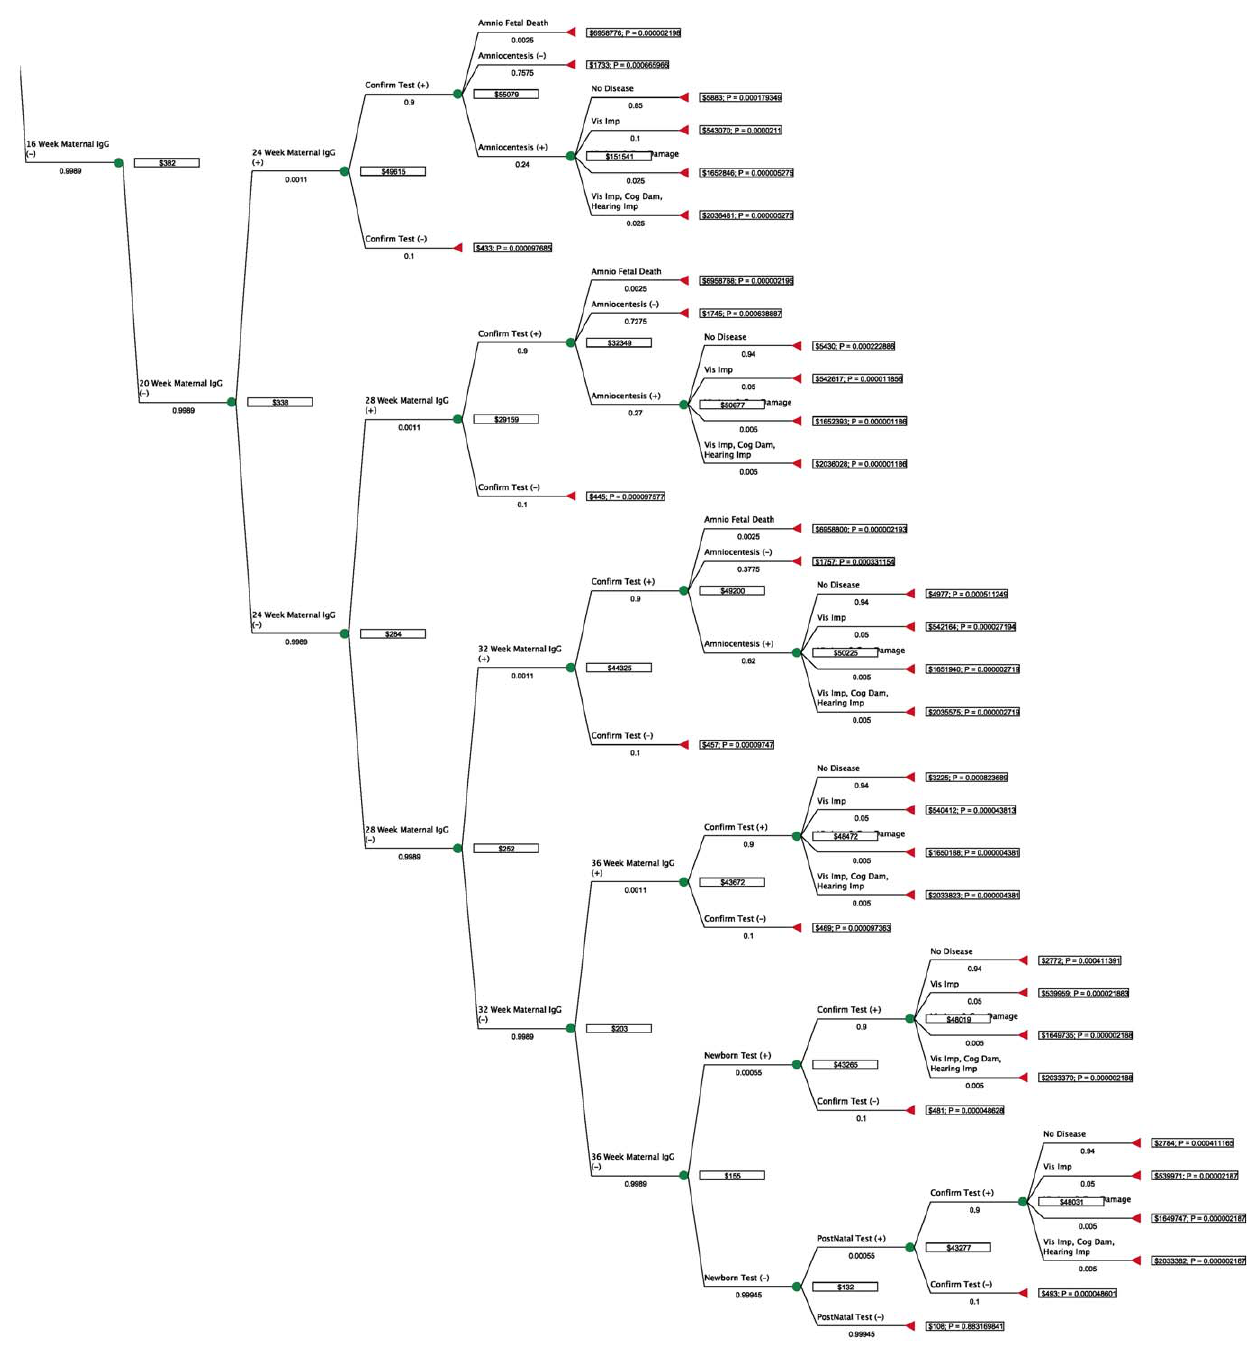
Figure 4. Decision tree with monetary values for costs and optimal path (bottom).